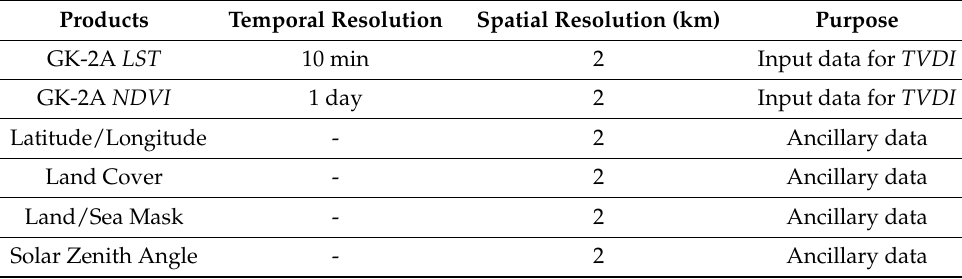
Table 1. Input and ancillary data for the GK-2A TVDI calculation.